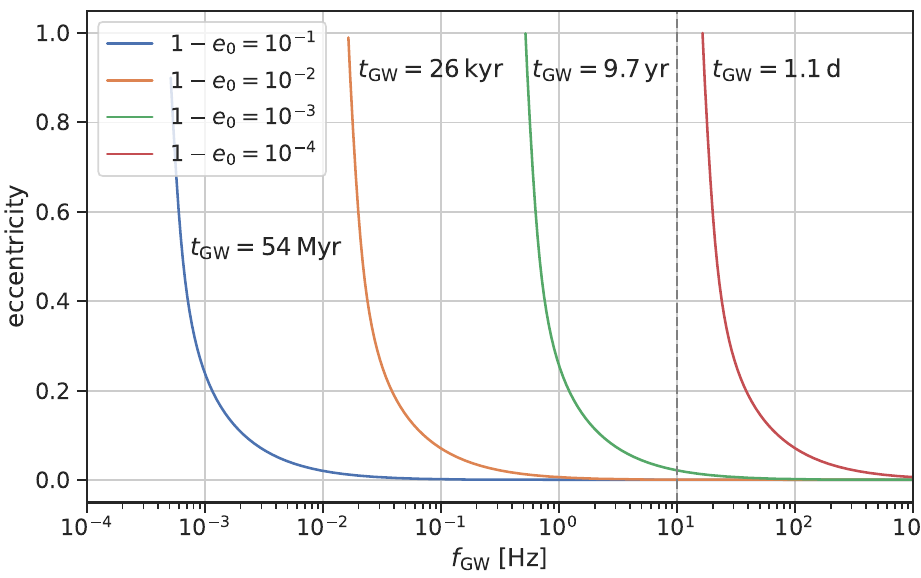
Figure 9. Eccentricity as a function of peak GW frequency for inspiralling binaries. Each curve indicates a binary with the same semimajor axis (1 au), but different initial eccentricity, as indicated in the legend. Coalescence timescales for each initial eccentricity are written next to the respective curves. The curves were calculated using the equations in Peters [414] and the fitting formula for the peak harmonic GW frequency in Hamers